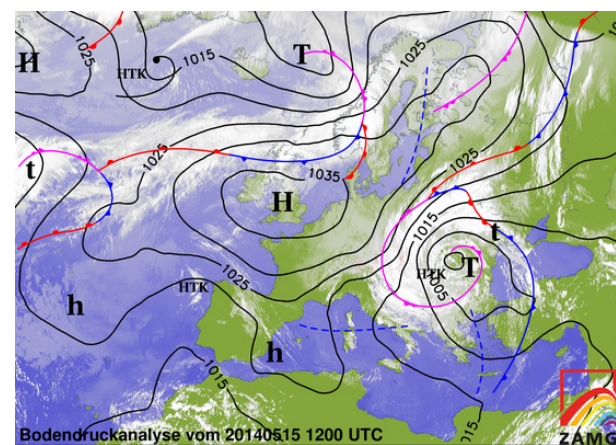
Figure 11. Satellite image (MSG IR), surface pressure analysis and frontal zones for 15 May 2014 at 12:00UTC.